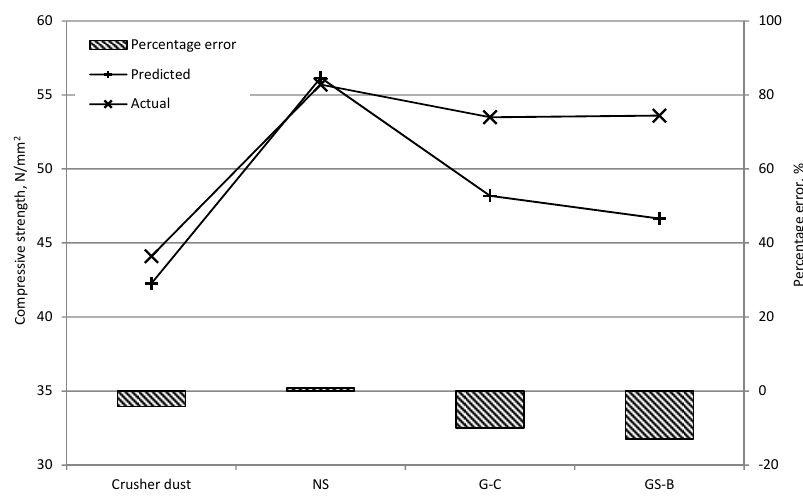
Figure 11. Predicted and actual compressive strength values for validation mixtures.